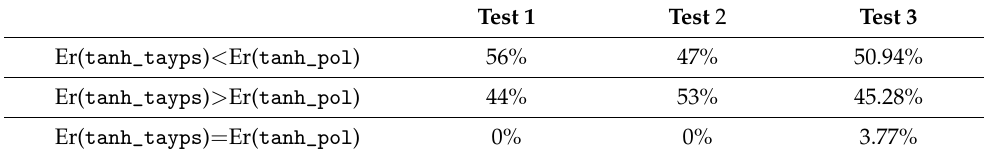
Table 6. The relative error comparison for the three tests between tanh_tayps vs. tanh_pol . Test 1 Test 2 Test 3 Er( tanh_tayps ) < Er( tanh_pol ) 56% 50.94%